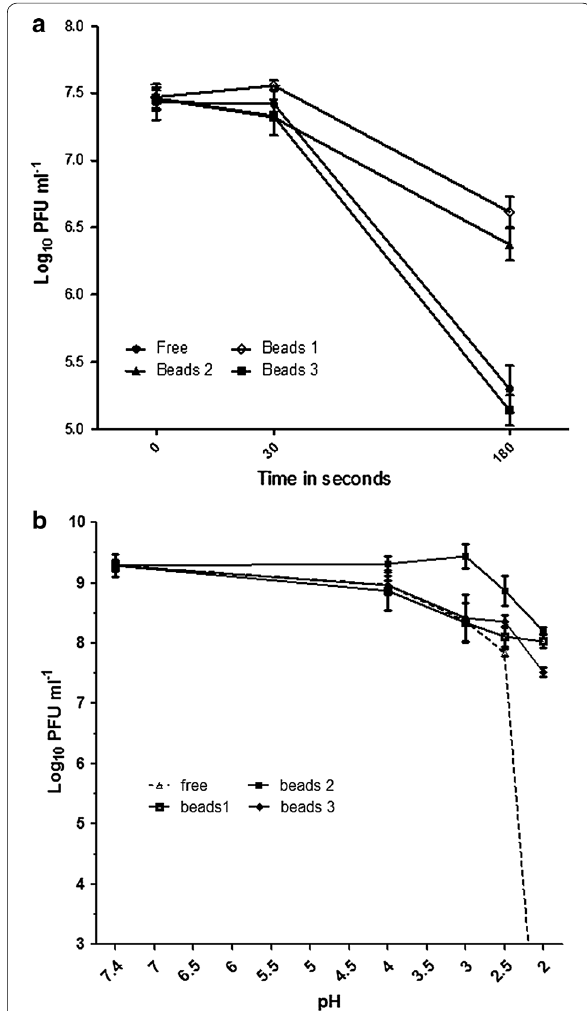
Fig. 5 a The stability of non‑encapsulated and encapsulated bacteriophages against high temperature (80 °C) for 3 min. b Low pH stability of the non‑encapsulated and encapsulated bacteriophages 1 h at 37 °C. Limit of detection is < 10 3 PFU mL −